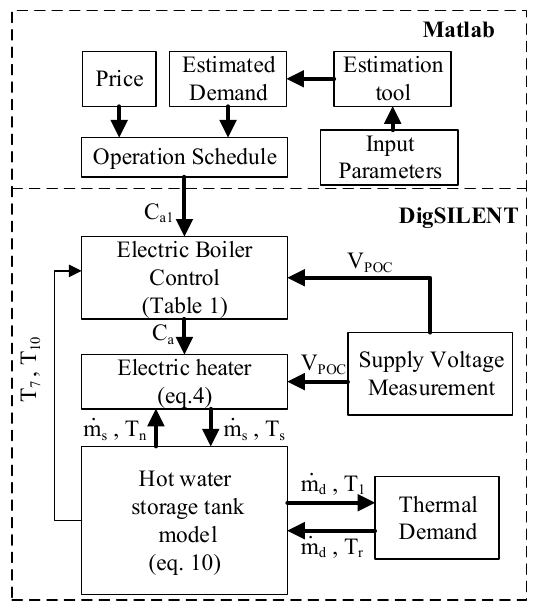
Figure 15. System implementation for flexible operation of